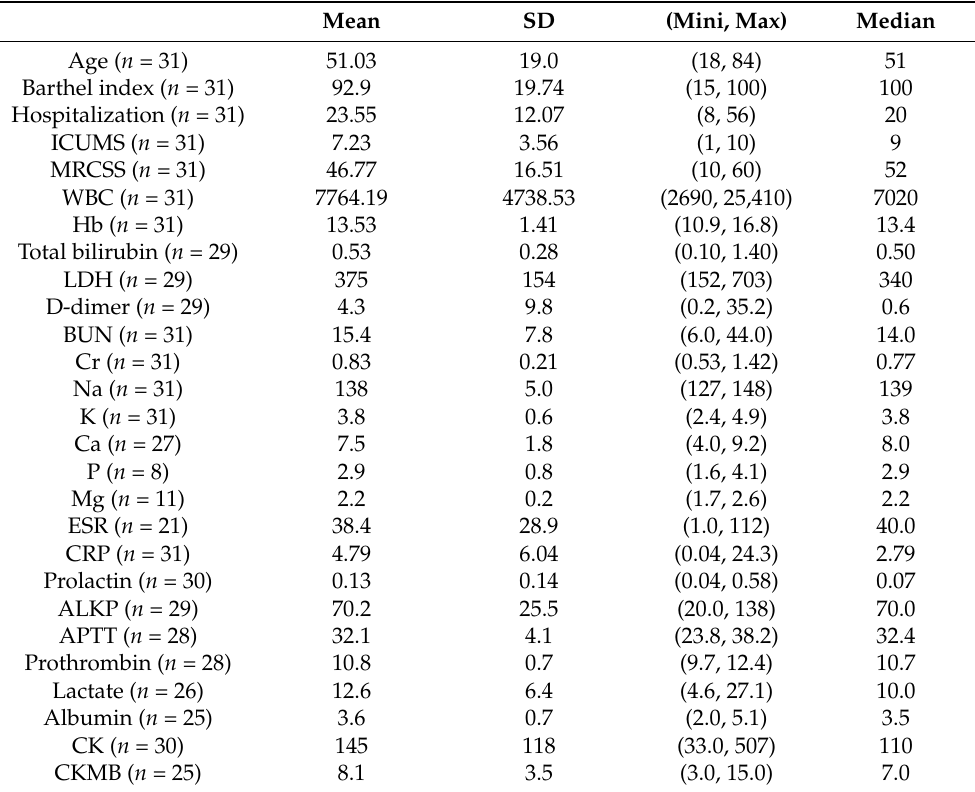
Figure 1. The flowchart for enrollment of our study subjects. Table 1. The clinical characteristics and the initial profiles of the study subjects.